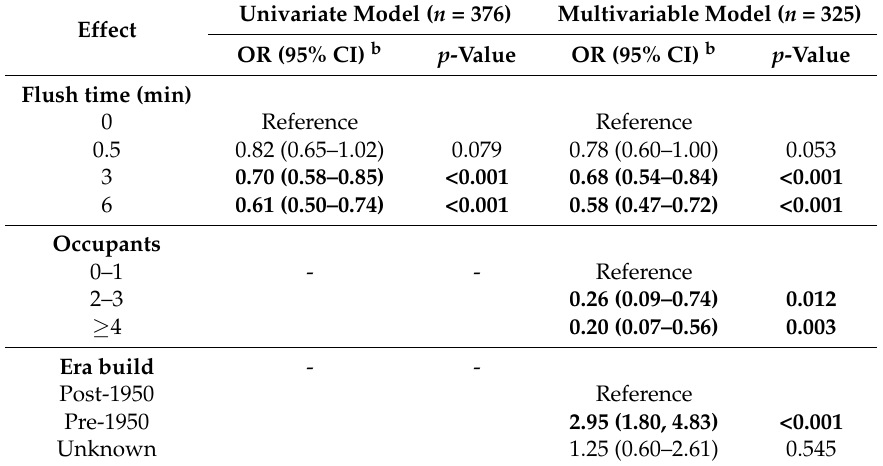
Table 4. Factors associated with percent of homes with detectable water lead level (WLL) ( ≥ 1 ppb) a